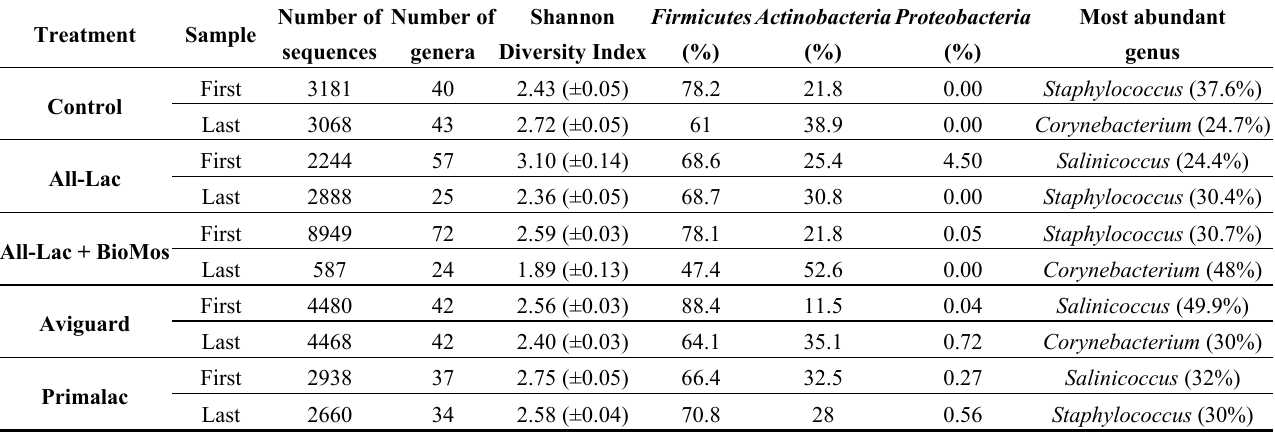
Table 7. 16S rRNA composition of first and last litter sample from broiler chickens raised in research housing and administered probiotics or